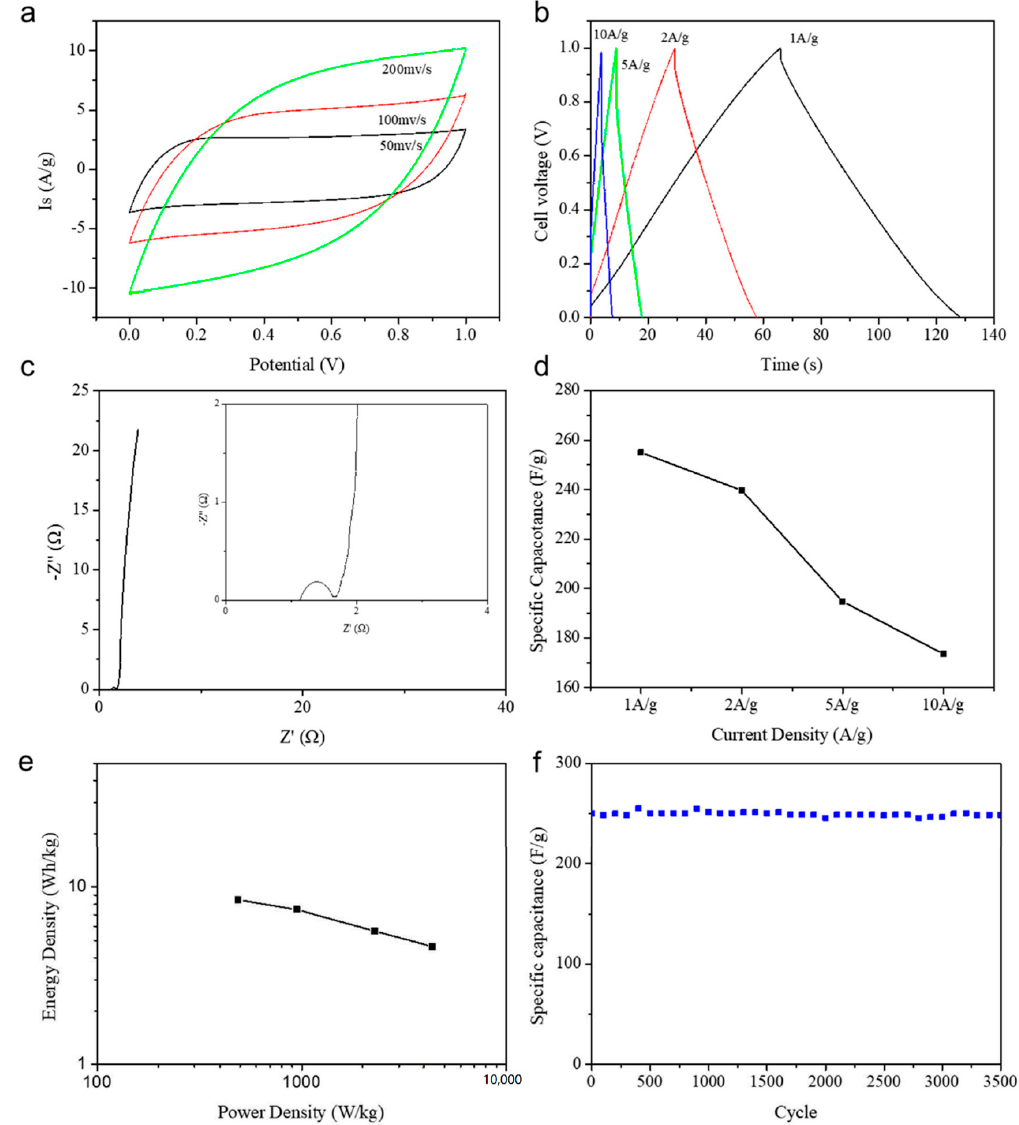
Figure 9. Electrochemical properties of the N/P/S-PBC//N/P/S-PBC supercapacitor measured using a two-electrode system in a 2.0 M H 2 SO 4 aqueous electrolyte. ( a ) CV curves at different scan rates. ( b ) Galvanostatic charge–discharge curves at different current densities. ( c ) Electrochemical impedance spectra. ( d ) Variation in specific capacitance against current density. ( e ) Ragone plot. ( f ) Cycling performance at a current density of 1.0 A/g.